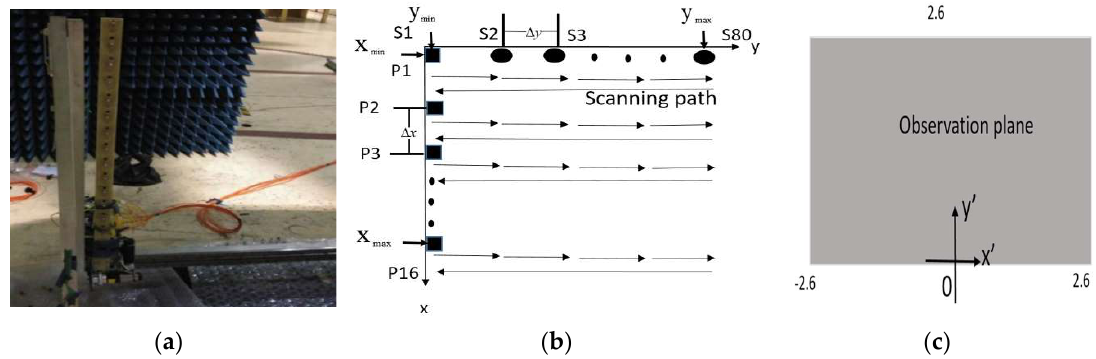
Figure 3. The probes. ( a ) the 16 × 1 probes; ( b ) the scan path; ( c ) observation plane.